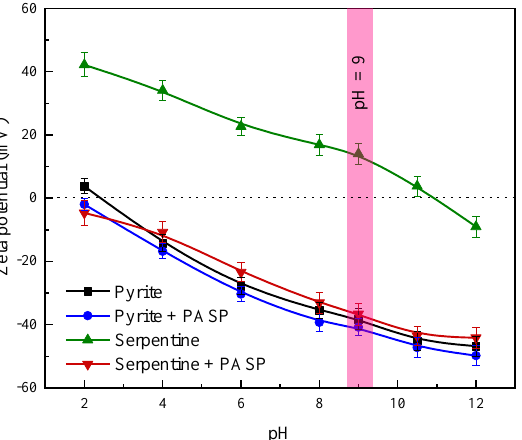
Figure 6. Effect of PASP on the zeta potentials of pyrite and serpentine under different pHs ([PASP] = 15 mg/L).